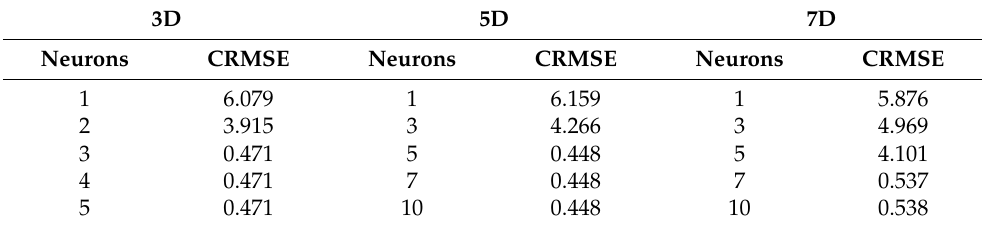
Table 16. CRMSE for imaginary part approximations with 3D, 5D and 7D scenarios.